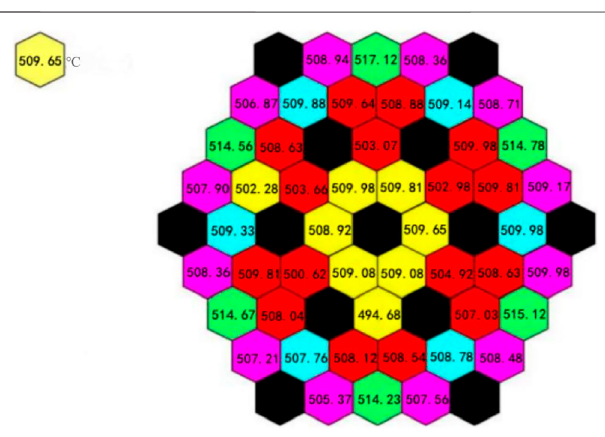
FIGURE12| Maximumoutlettemperaturedistributionat36groupsofpower.